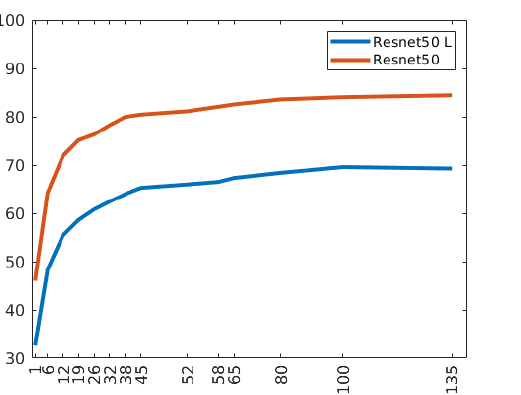
Figure 10. Accuracy trend as the average number of tiles per class of the training set increases.